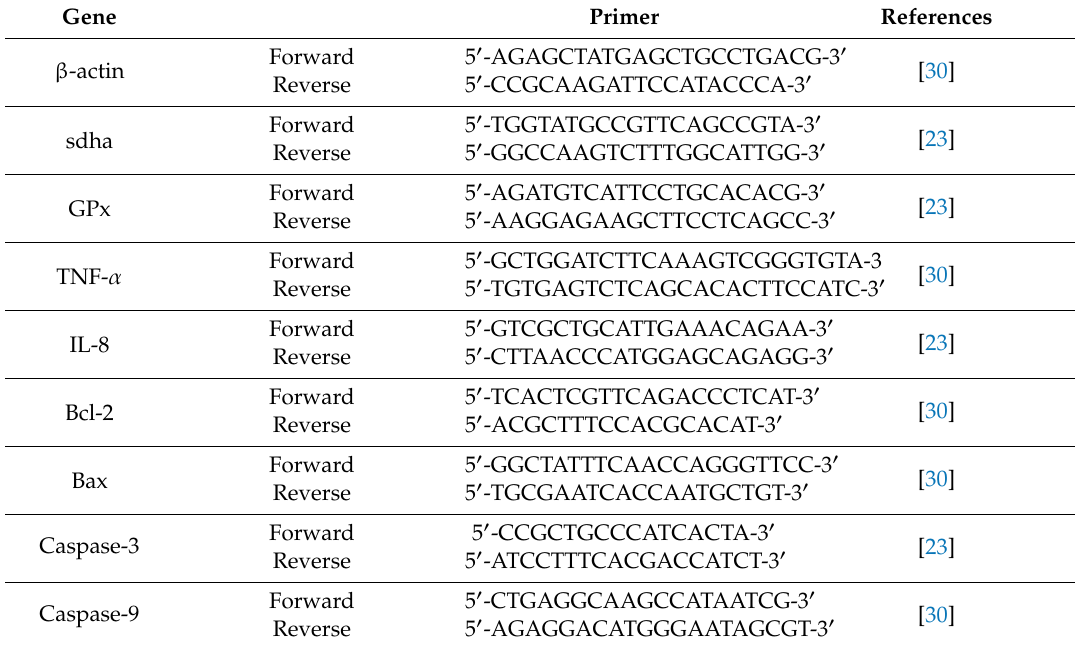
Table 3. Sequences of the primer pairs used in the qRT-PCR.